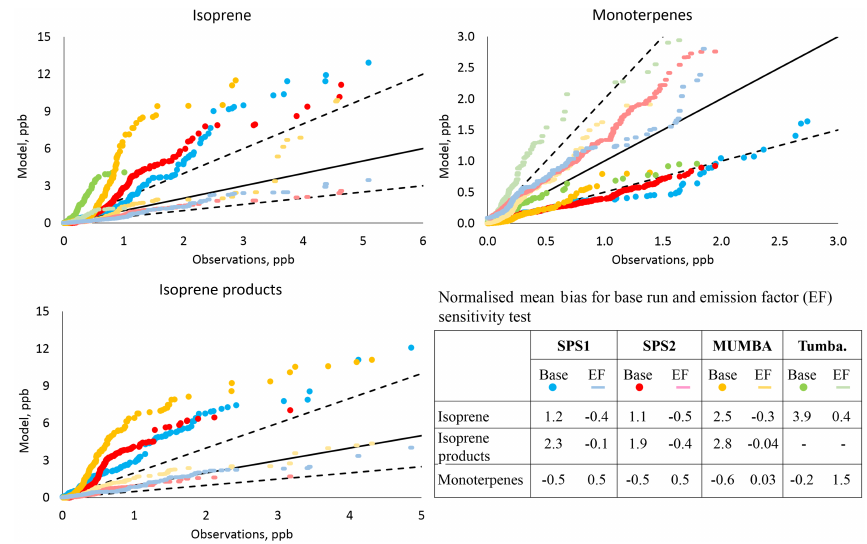
Figure 8. Quantile–quantile plots to show relationship between modelled and observed biogenic gases. The base run are dots and the emission factor sensitivity study are the dashes. The solid black line is the 1:1 line; dashed black lines indicate a factor of ± 2. Note: isoprene products are MVK + MACR. The y axis on isoprene chart is reduced to 15ppb to aid visual comparison, as modelled MUMBA data reach